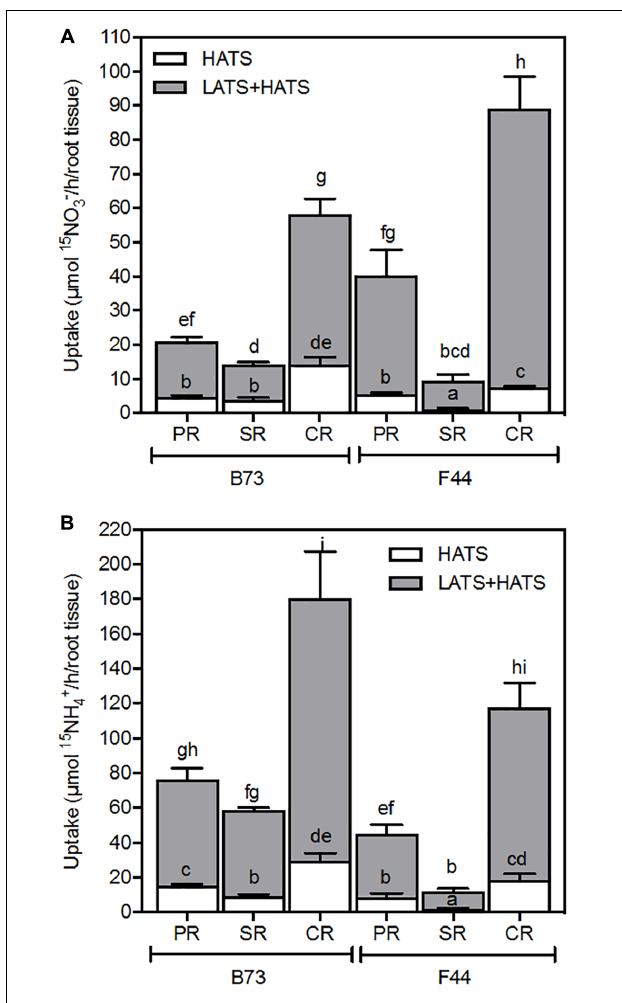
FIGURE 6 | Nitrate (A) and ammonium (B) uptake capacity of B73 and F44 in the PR, SR, and CR root tissues. Values are means ( ± SE) from five individual plants. Different letters indicate significant differences among means at P < 0.05